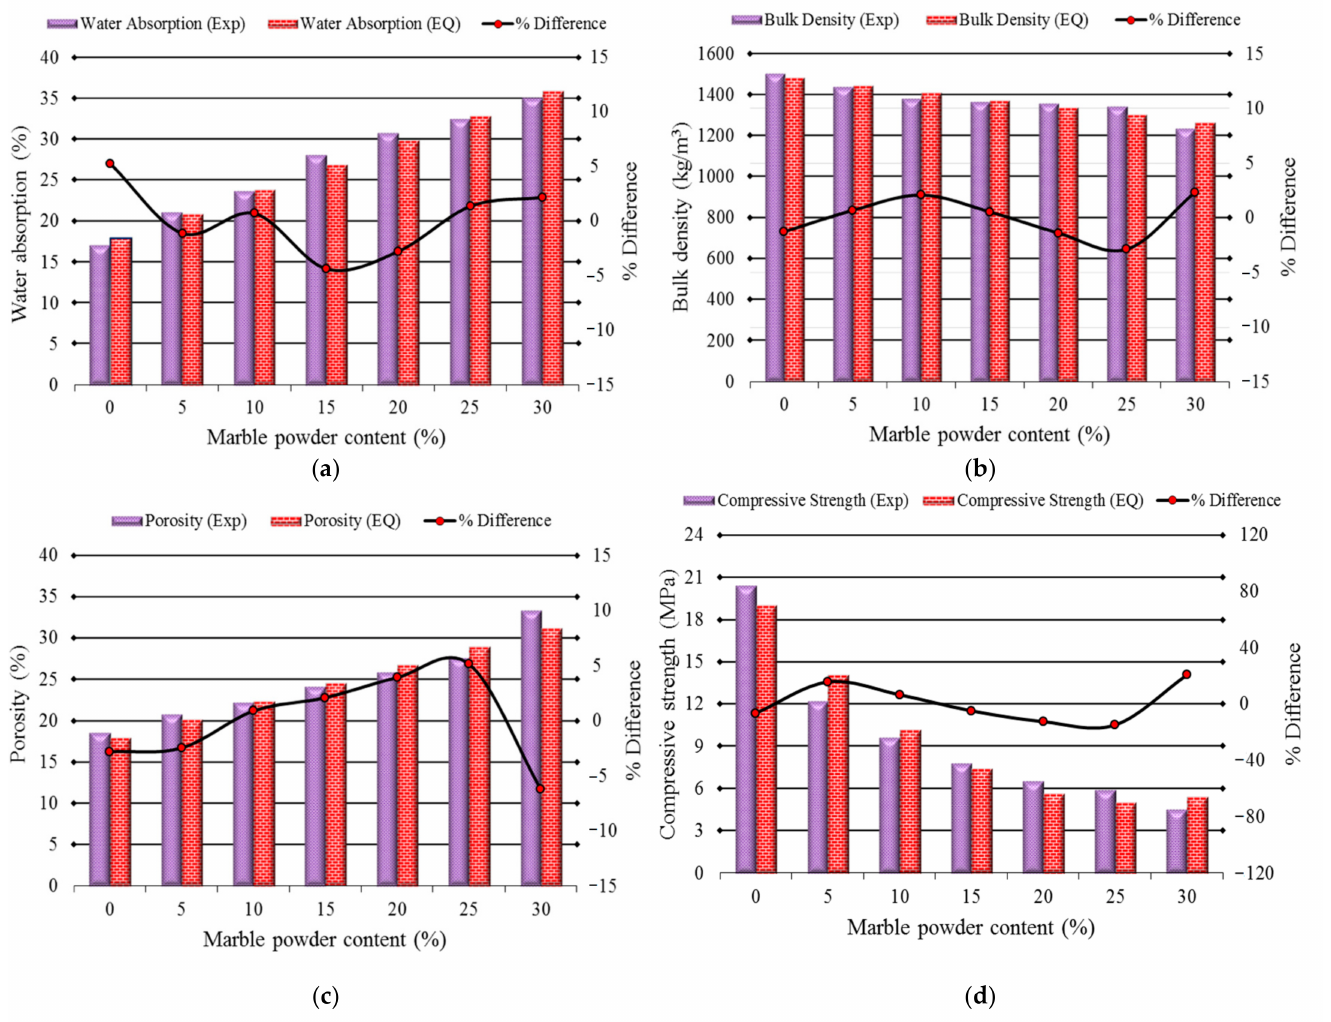
Figure 12. A comparison of the experimental results and those obtained from the laboratory tests for: ( a ) water absorption; ( b ) bulk density; ( c ) porosity ( d ) compressive